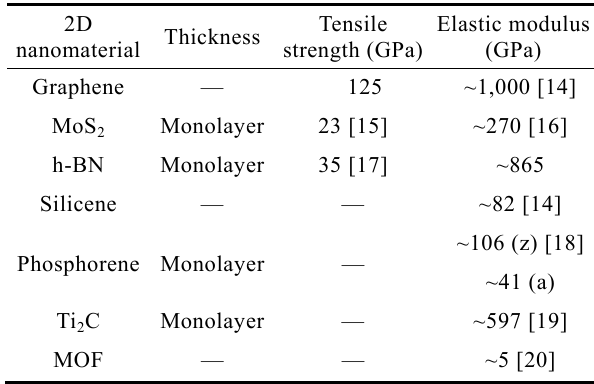
Mechanical properties of some typical 2D nano-